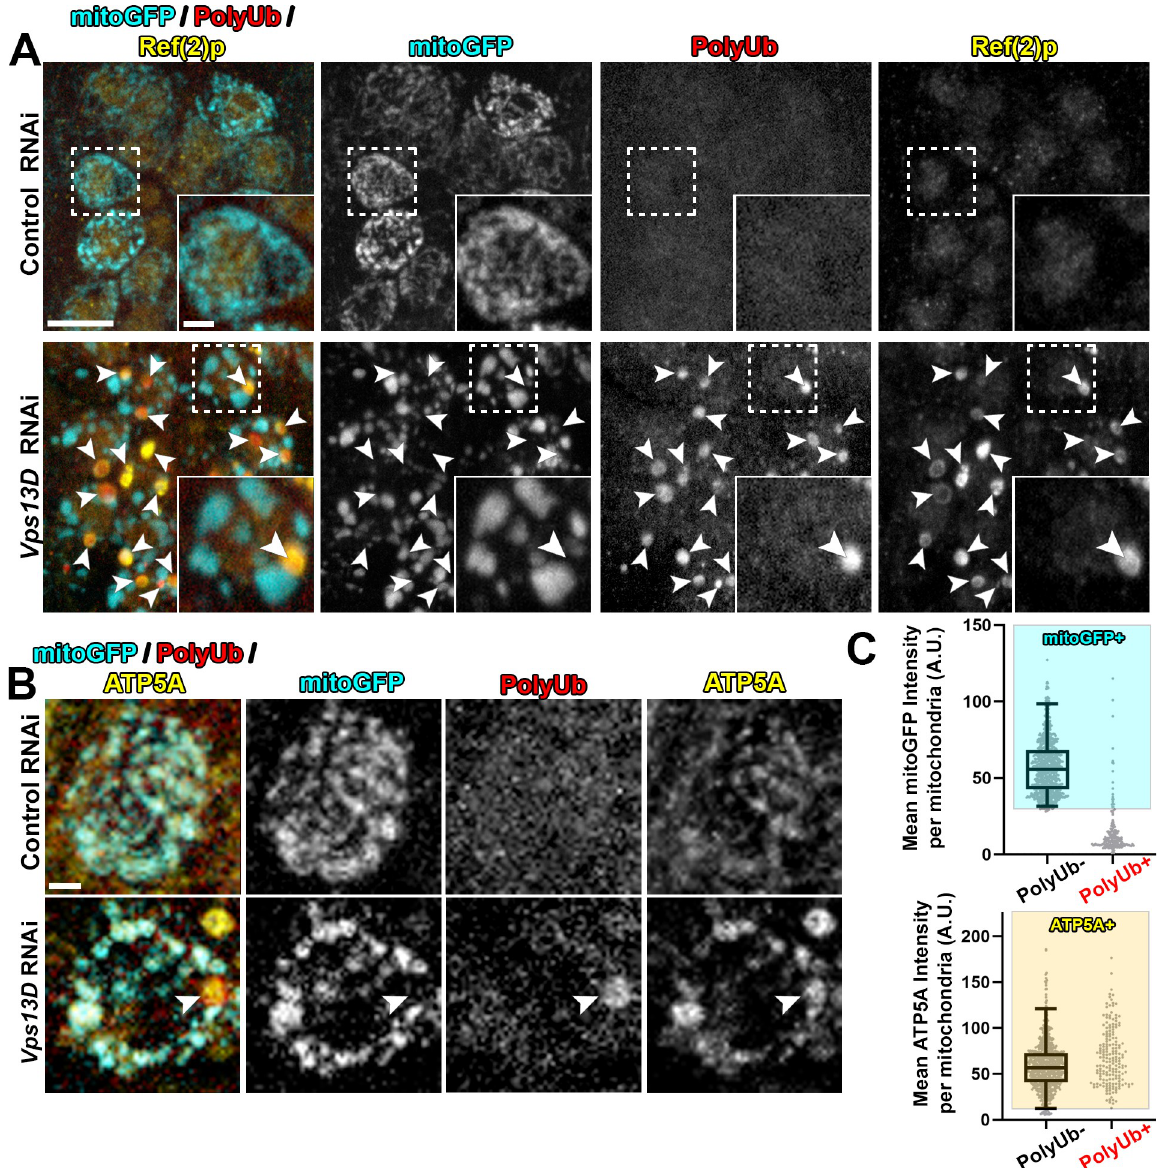
Fig 1. Neurons depleted for Vps13D contain mitophagy intermediates lacking matrix. Representative images of motoneurons in the larval VNC which co-express UAS-mitoGFP (cyan) with UAS-luciferase RNAi (control) (BL# 31603) versus UAS-Vps13D RNAi (BL# 38320), via the D42-Gal4 driver. A ) VNC tissue was stained for polyubiquitin (PolyUb, FK1, red) and Ref(2)p (p62 homolog, yellow). Dashed box outlines a single Gal4-expressing neuronal cell body that is shown in high magnification in the inset in the bottom right corner. Arrowheads indicate examples of PolyUb+ objects (PolyUb+/Ref(2)p+/mitoGFP-). Vps13D RNAi expressing neurons contained on average 1.88 PolyUb+ objects per cell body (n = 239 neurons from 5 ventral nerve cords (VNCs)), while such objects were never observed in neurons expressing control RNAi. 98.8% of PolyUb+ objects were Ref(2)p+, n = 485 PolyUb+ objects from 5 larval VNCs. Scale bars = 10 μ m, 2 μ m. B) Co-staining for mitoGFP (cyan), polyubiquitin (PolyUb, red) and endogenous IMM protein ATP5A (yellow). The arrowhead highlights an example PolyUb+ object, which contains ATP5A, but lacks mitoGFP. Scale bar = 2 μ m. C) Distribution of mean intensities for mitoGFP (top) and ATP5A (bottom) from mitochondria in motoneurons. The right column shows objects selected based on positivity for PolyUb. The left column shows the population of conventional (PolyUb-) mitochondria (selected by similar criteria). Based on the criteria of > 2.5% of the intensity distribution of the PolyUb- mitochondria population (shaded boxes), PolyUb+ objects were classified as + for mitoGFP and/or ATP5A if they were within the shaded box. n = 809 mitochondria and 184 PolyUb+ objects from 5 larval